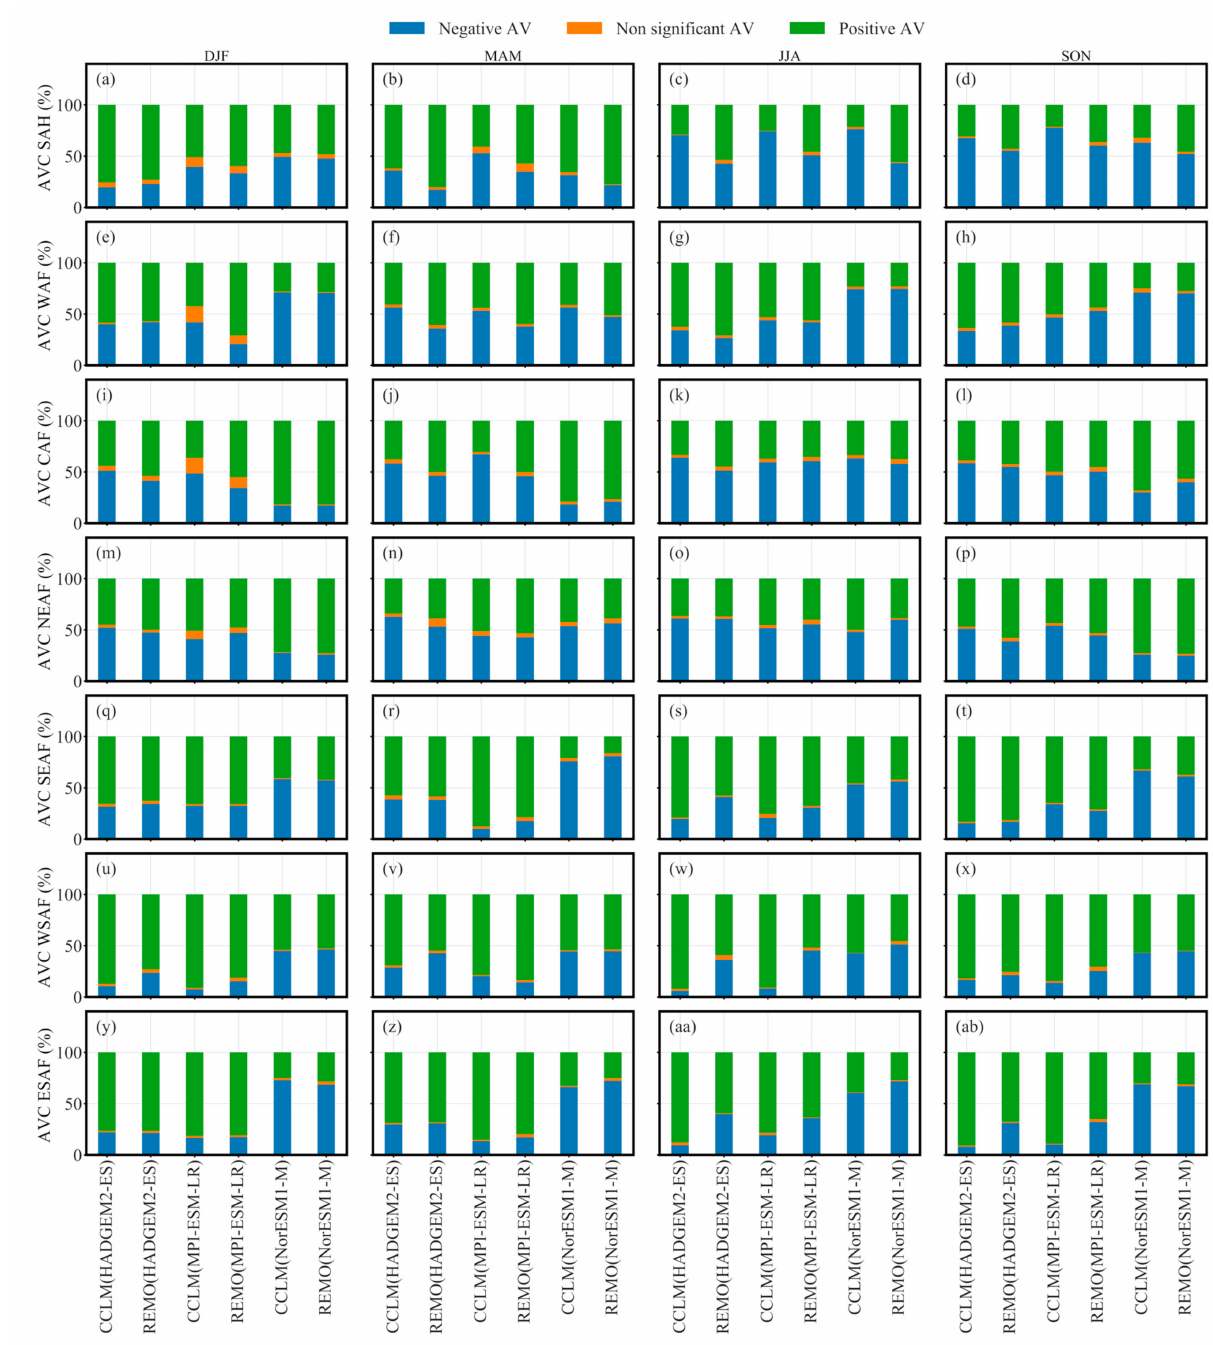
Figure 9. Added value coverage percentage per sub-region indicated in Figure 1 with CHIRPS as the observational reference. ( a – d ) Sahara (SAH) region, ( e – h ) West Africa (WAF) region, ( i – l ) Central Africa (CAF) region, ( m – p ) Northern East Africa (NEAF), ( q – t ) Southern East Africa (SEAF), ( u – x ) Western South Africa, ( y – ab ) Eastern South Africa